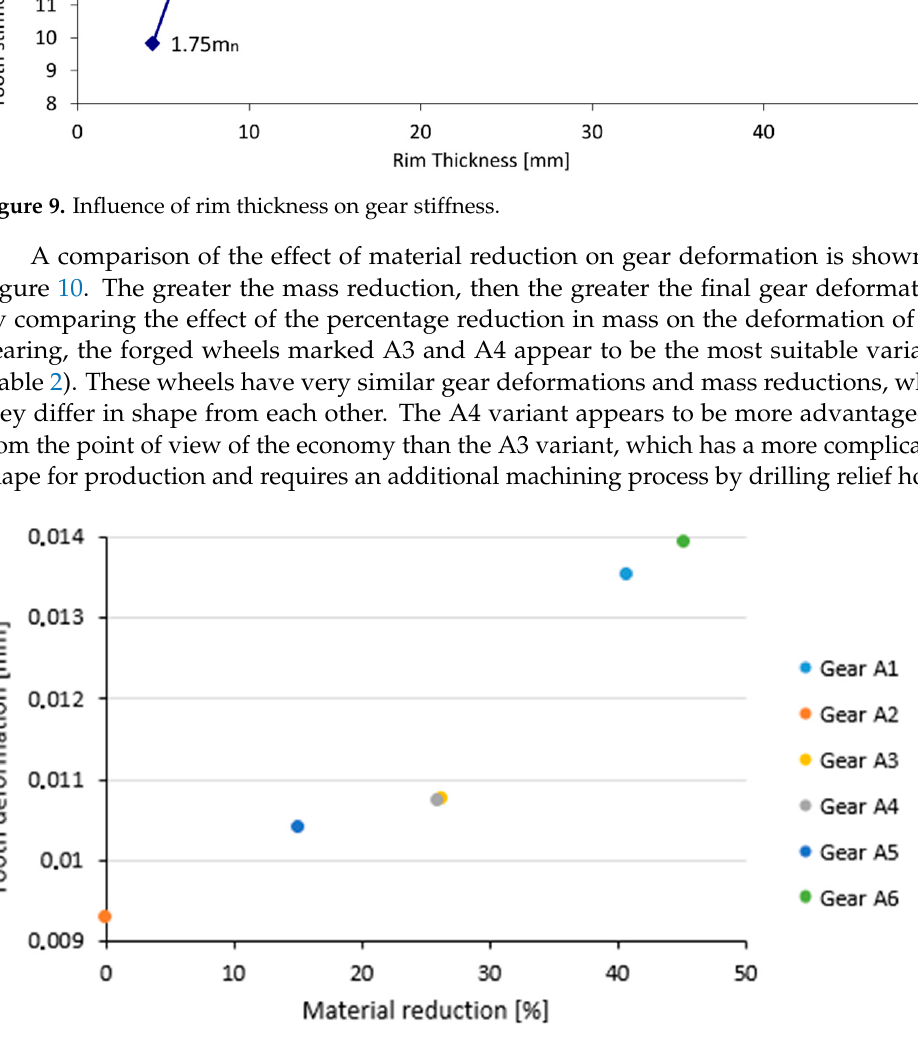
Figure 10. Influence of material reduction on maximum gear deformation.